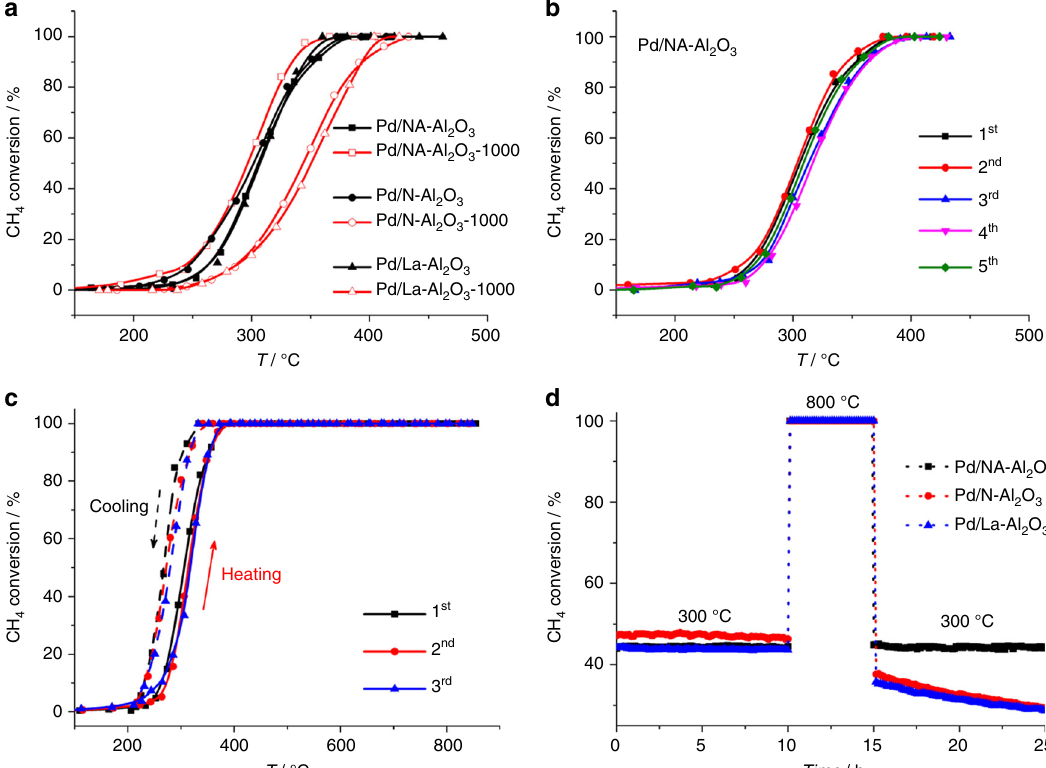
Fig. 5 Catalytic combustion of methane on Pd/Al 2 O 3 nanocatalysts. a CH 4 conversion vs reactor temperature. b Repeating ignition − extinction cycles of methane conversion on Pd/NA-Al 2 O 3 . c Light-off curves of methane conversion on Pd/NA-Al 2 O 3 at temperatures between 100 – 850 °C. d Long-term combustion of methane at 300-800-300 °C on Pd/NA-Al 2 O 3 , Pd/N-Al 2 O 3 and Pd/La-Al 2 O